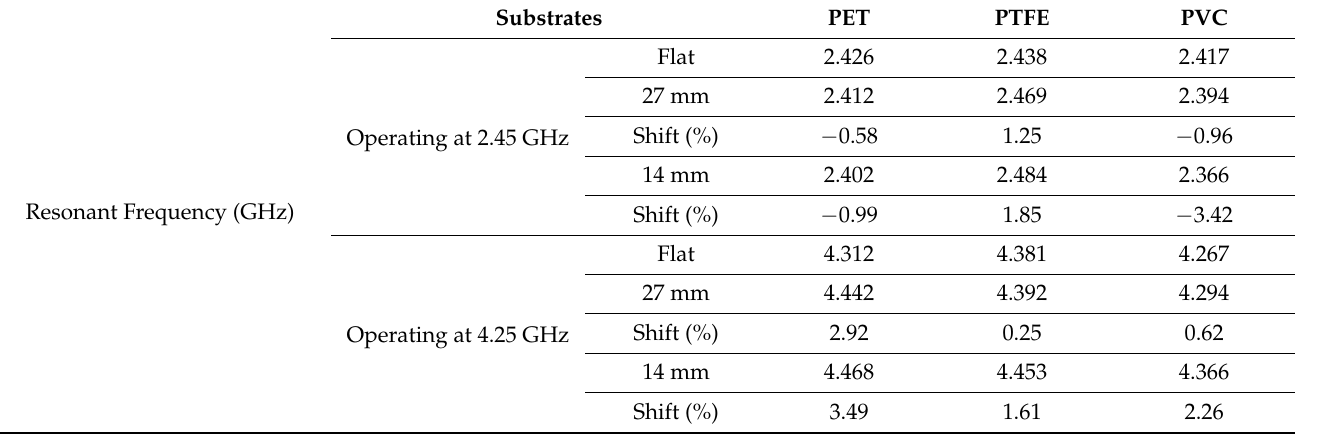
Table 3. Percentage (%) FS in resonant frequencies for flexible antennas on PET, PTFE, and PVC substrates at 3 operating frequencies with bend conditions of 27 and 14